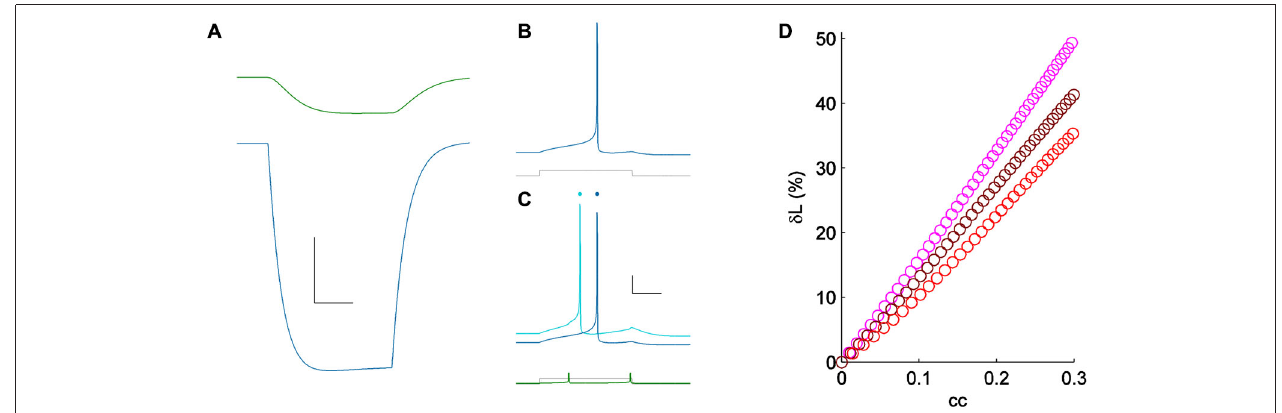
FIGURE 4 | (A) Coupling demonstrated by a hyperpolarizing current pulse in a pair of simple Hodgkin-Huxley neurons; cc = 0.15. Scale bar 2 mV, 25 ms. (B) Spiking one of the model cells (blue) for a minimal input (lower, gray); the coupled neuron was quiet. (C) Spiking in the same cell (light blue) for the same current pulses as in (A) (lower, shown in gray), with the coupled neighbor also spiking (lower, shown in green). Responses from (A) are repeated, vertically offset, for clarity (dark blue). Scale bar 10 mV, 25 ms. (D) δ L plotted against coupling coefficient in the modeled pair, for three values of excitability [sodium conductances of 60 (pink), 75 (maroon) and 90 (red) µ S/cm 2